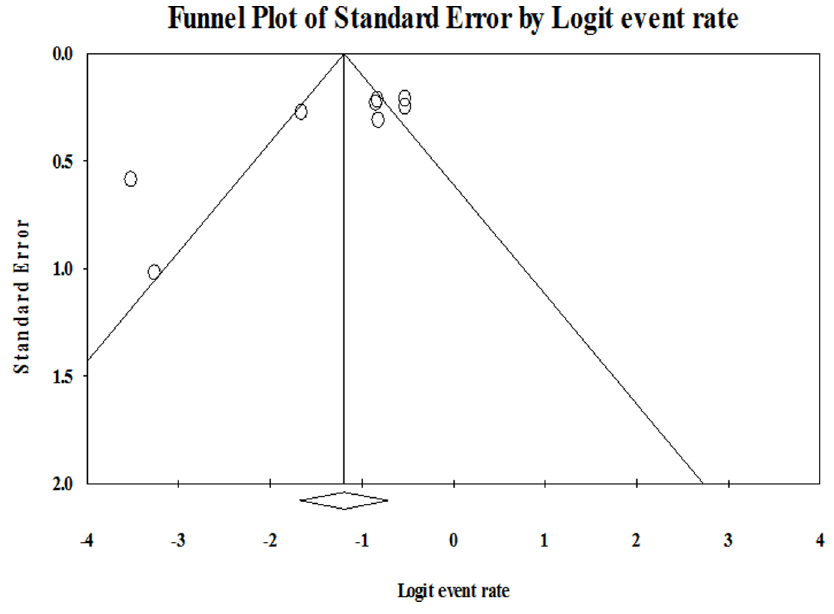
Figure 3. Funnel plot to assess publication bias across prevalence studies.